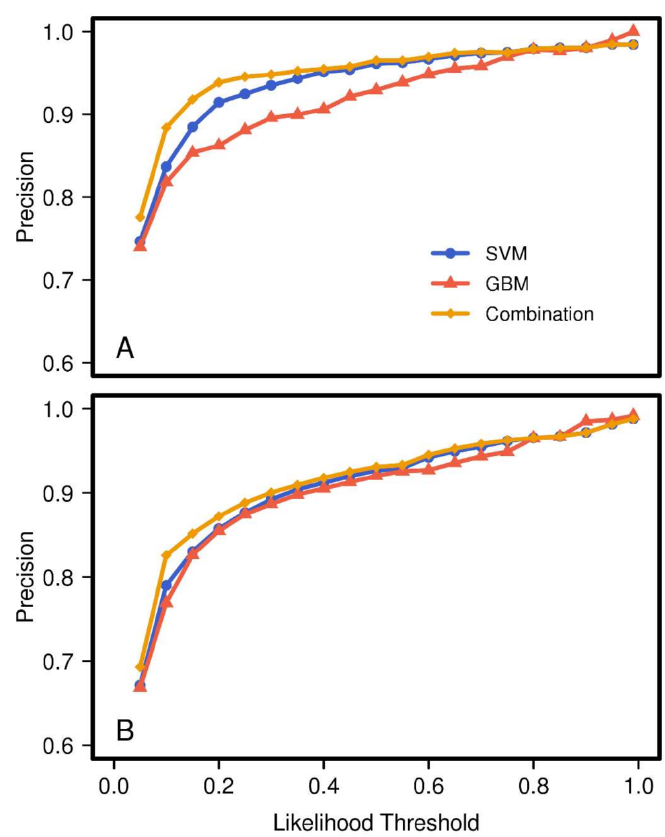
Figure 4. Effect of likelihood threshold selection on the proportion of training pixels of a given predicted class that truly belong to the class (precision) for both Brown ( A ) and Leafless ( B ) predicted pixel classes, under the SVM, GBM, and combined models using a 10-fold cross-validation.